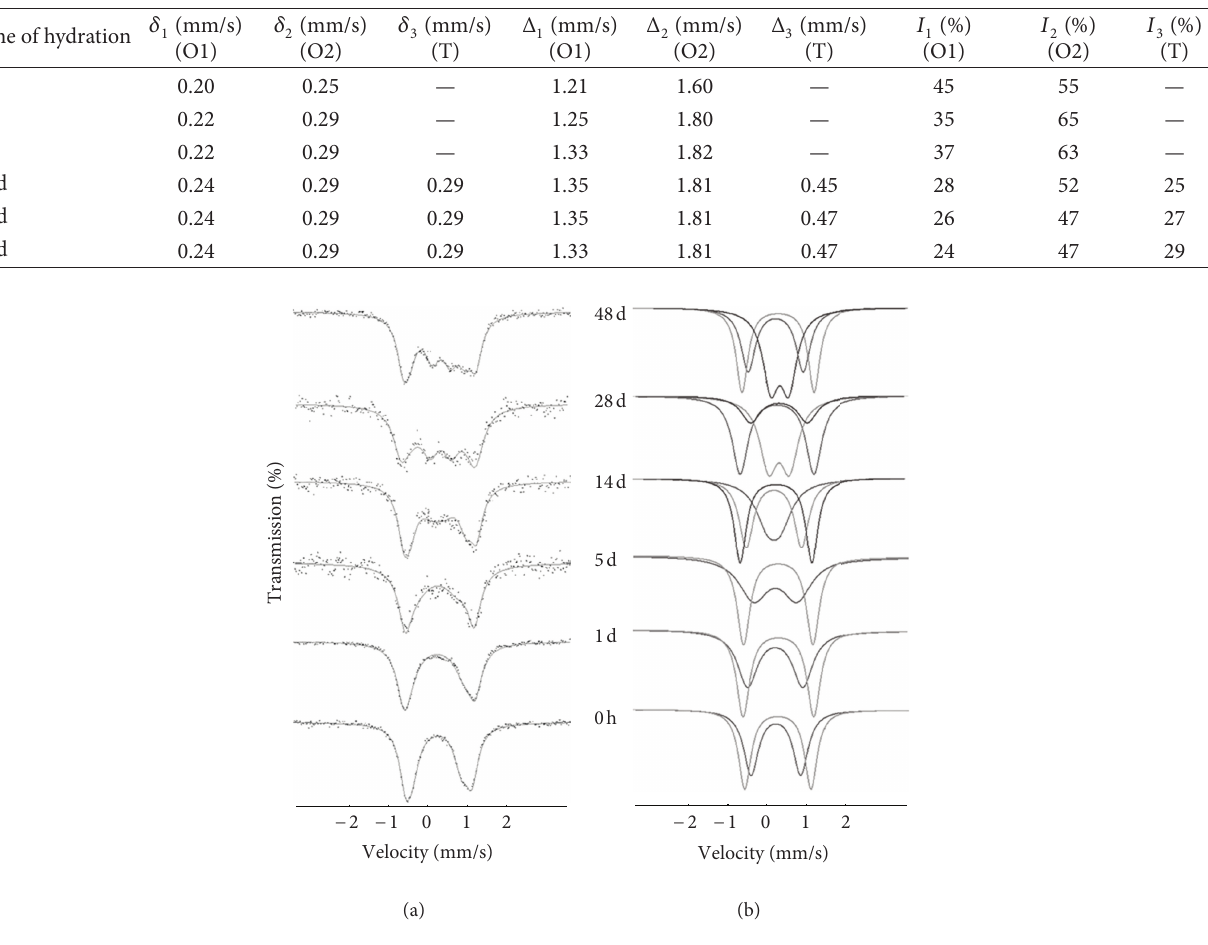
T 6: Mössbauer parameters of the of cement PC2 at different ages of hydration.